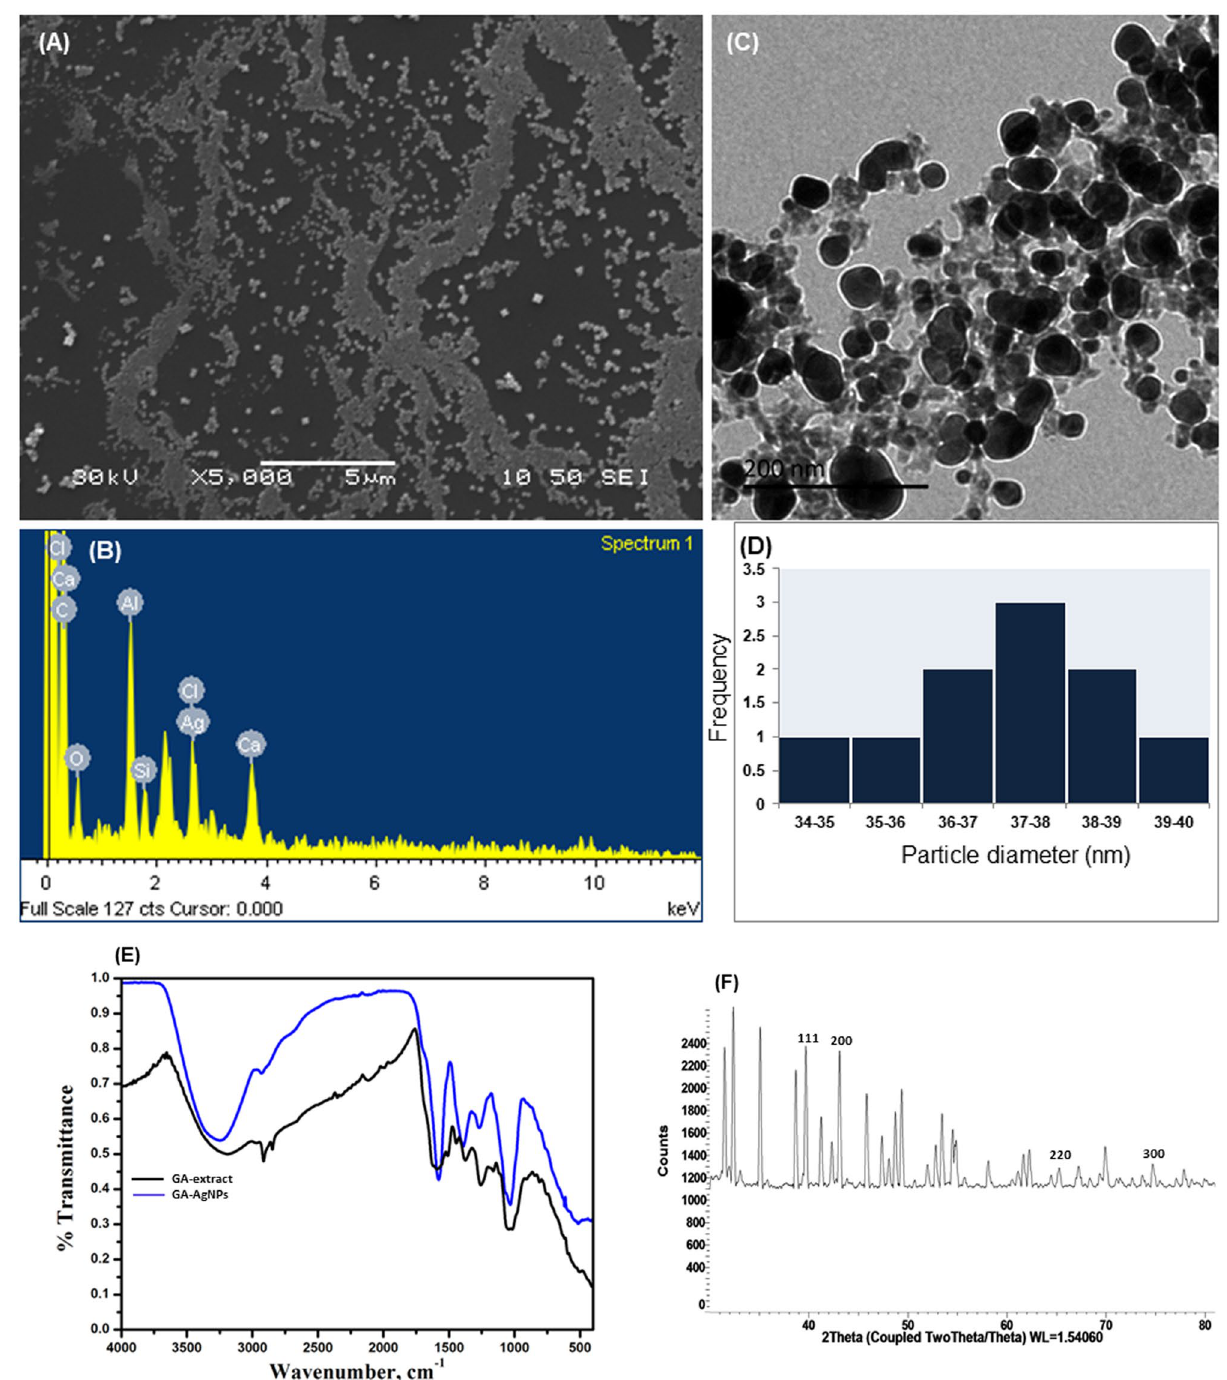
Figure 3. Characterization of phyto-fabricated GA-AgNPs: ( A ) SEM image, ( B ) EDX analysis, ( C ) TEM image, ( D ) particle size distribution, ( E ) FTIR spectral analysis, comparison with GA-extract and ( F ) X-ray diffraction